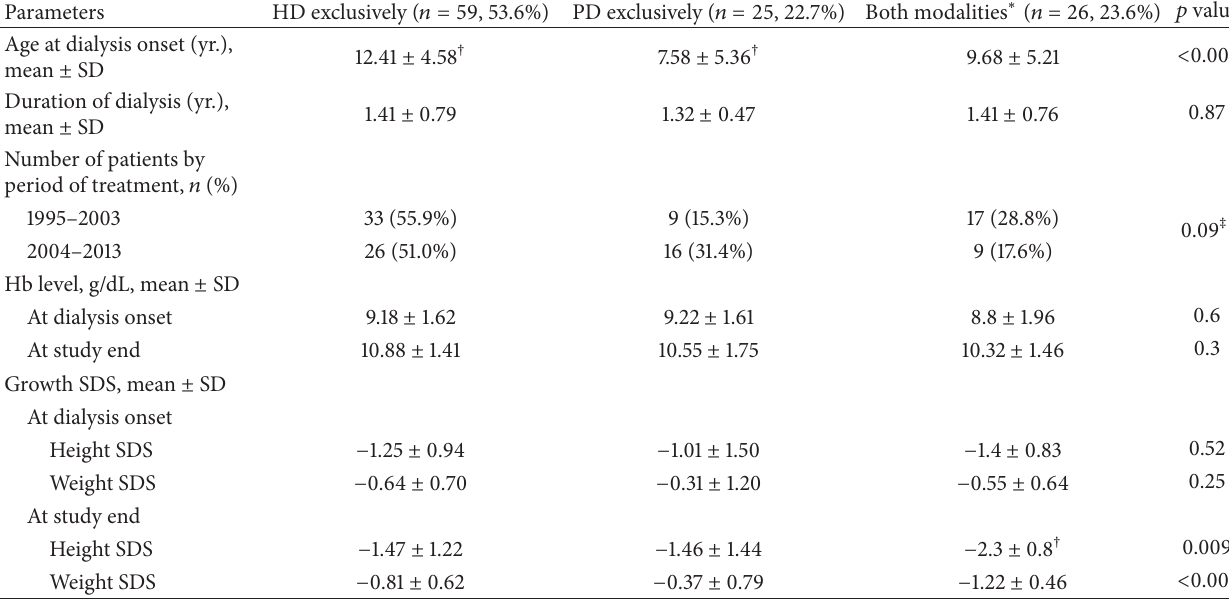
Table 2: Study parameters related to dialysis